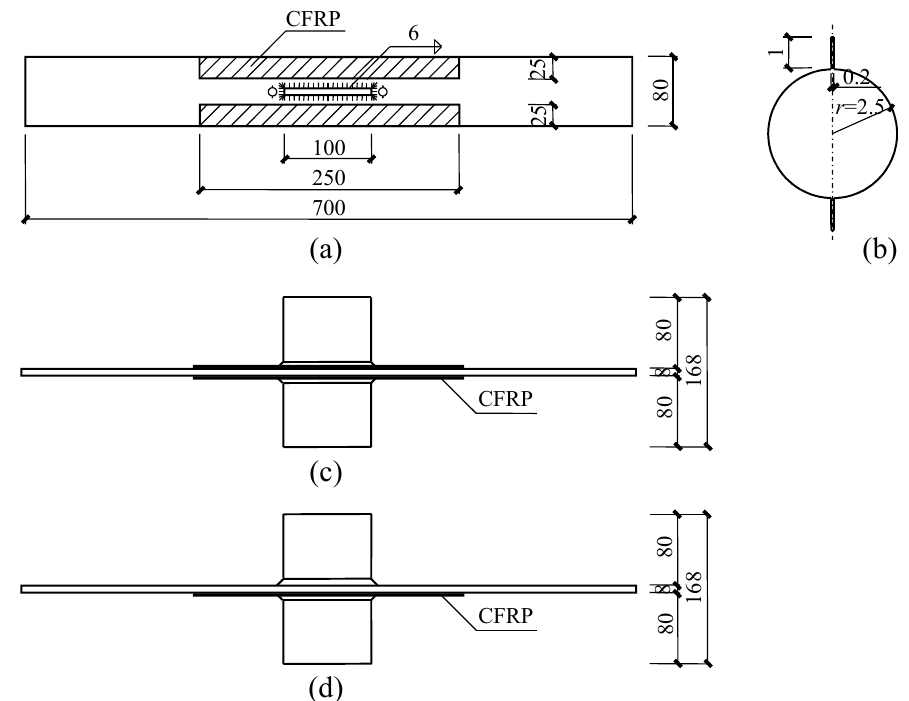
Figure 1. ( a ) Specimen geometry and dimensions (unit: mm, not to scale); ( b ) Initial notch; ( c ) Double-sided strengthened specimen; ( d ) Single-sided strengthened specimen.